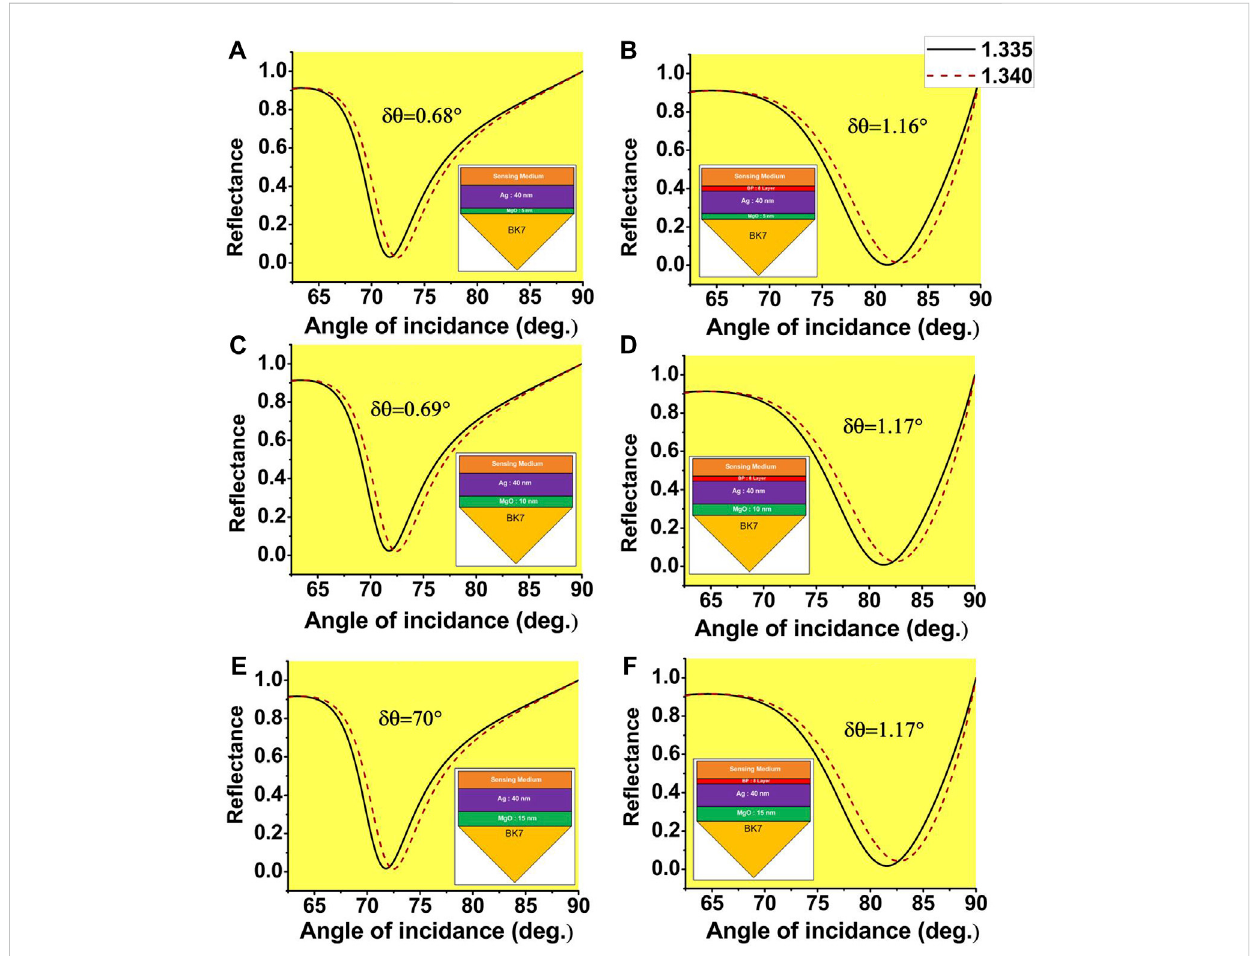
FIGURE 7 Variationofthere fl ectancewiththeangleoftheincidenceoftheprismfortwoRIoftheanalyte1.335and1.340.Whenthethicknessoftheadhesion layerofMgO andBPareconsideredas (A) MgO=5 nm,BP=0, (B) MgO =5 nm,BP=8layers, (C) MgO= 10 nm,BP=0, (D) MgO =10 nm,BP= 8layers, (E) MgO = 15 nm, BP = 0, (F) MgO = 15 nm, BP = 8 layers.